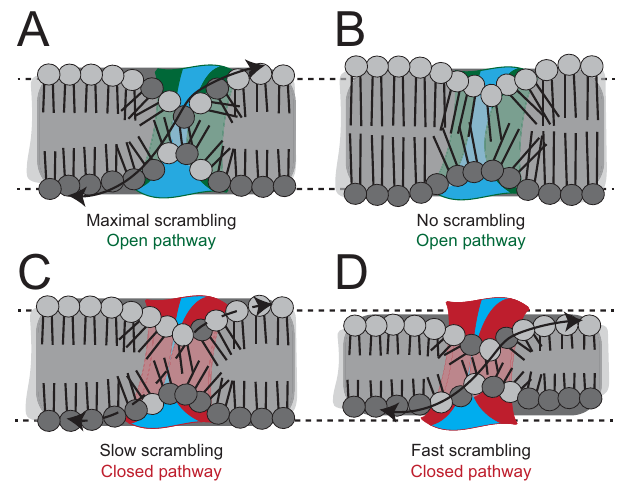
Fig. 7 TMEM16 scramblases enable scrambling by thinning the membrane. A – D Schematic representation of the open ( A , B colored in green) and closed pathways ( C , D colored in red) in membranes of different thickness. Outer and inner lea fl et lipid headgroups are colored in light and dark gray, respectively. Cyan denotes regions accessible to water. Arrows denote high (solid line), low (dashed line) or no (no line)